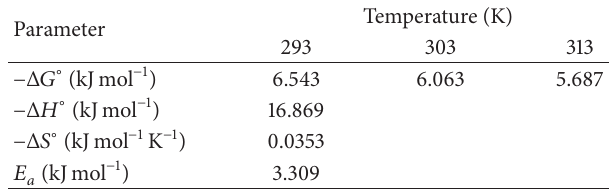
Table 5: Thermodynamic